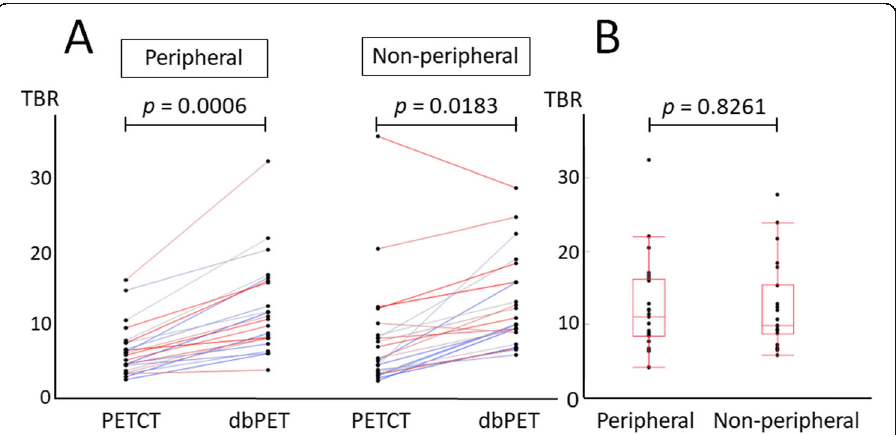
Fig. 5 Comparisons of tumour-to-background ratios (TBRs). a There were significant differences between TBRs of dbPET and whole-body PET/CT in both peripheral (12.38 ± 6.41 vs 6.73 ± 3.5, p = 0.0006) and non- peripheral (12.44 ± 5.94 vs 7.71 ± 7.1, p = 0.0183) groups. b There was no significant difference in the